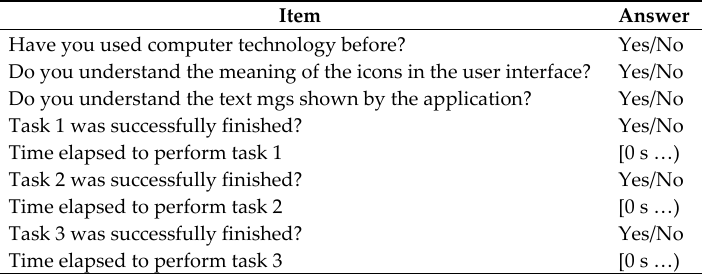
Table 2. Dependent variables identified in the